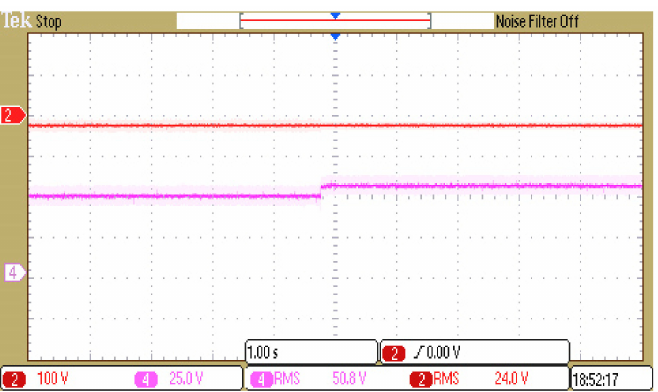
Figure 22. The output voltage waveform of load #1 and the input voltage waveform of DC–DC.